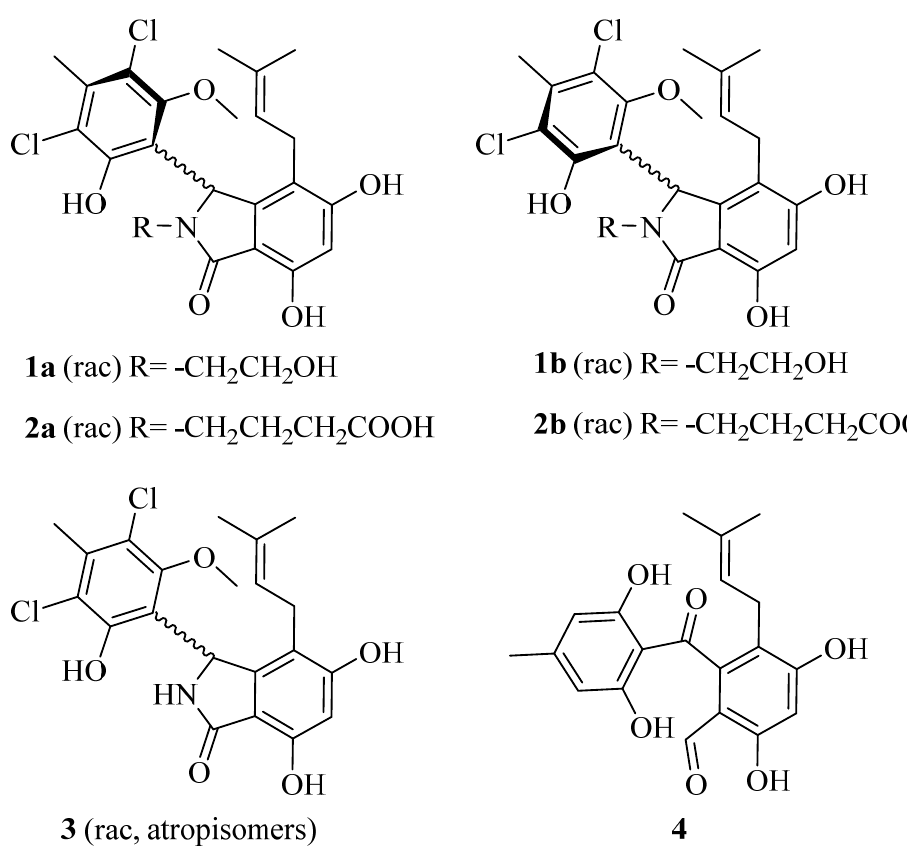
Figure 1. Structures of pestalachlorides A1a ( 1a ), A1b ( 1b ), A2a ( 2a ), A2b ( 2b ), and A ( 3 ) as well as SB87 ‐ H ( 4 ).